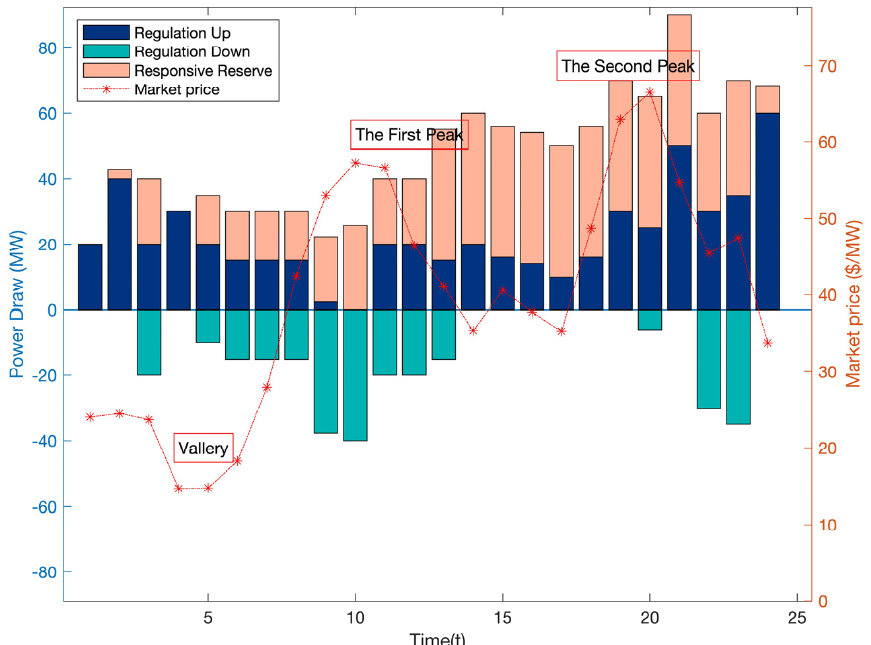
Figure 5. The regulation/responsive reserve result of Audi e-tron when considering uncertainties.